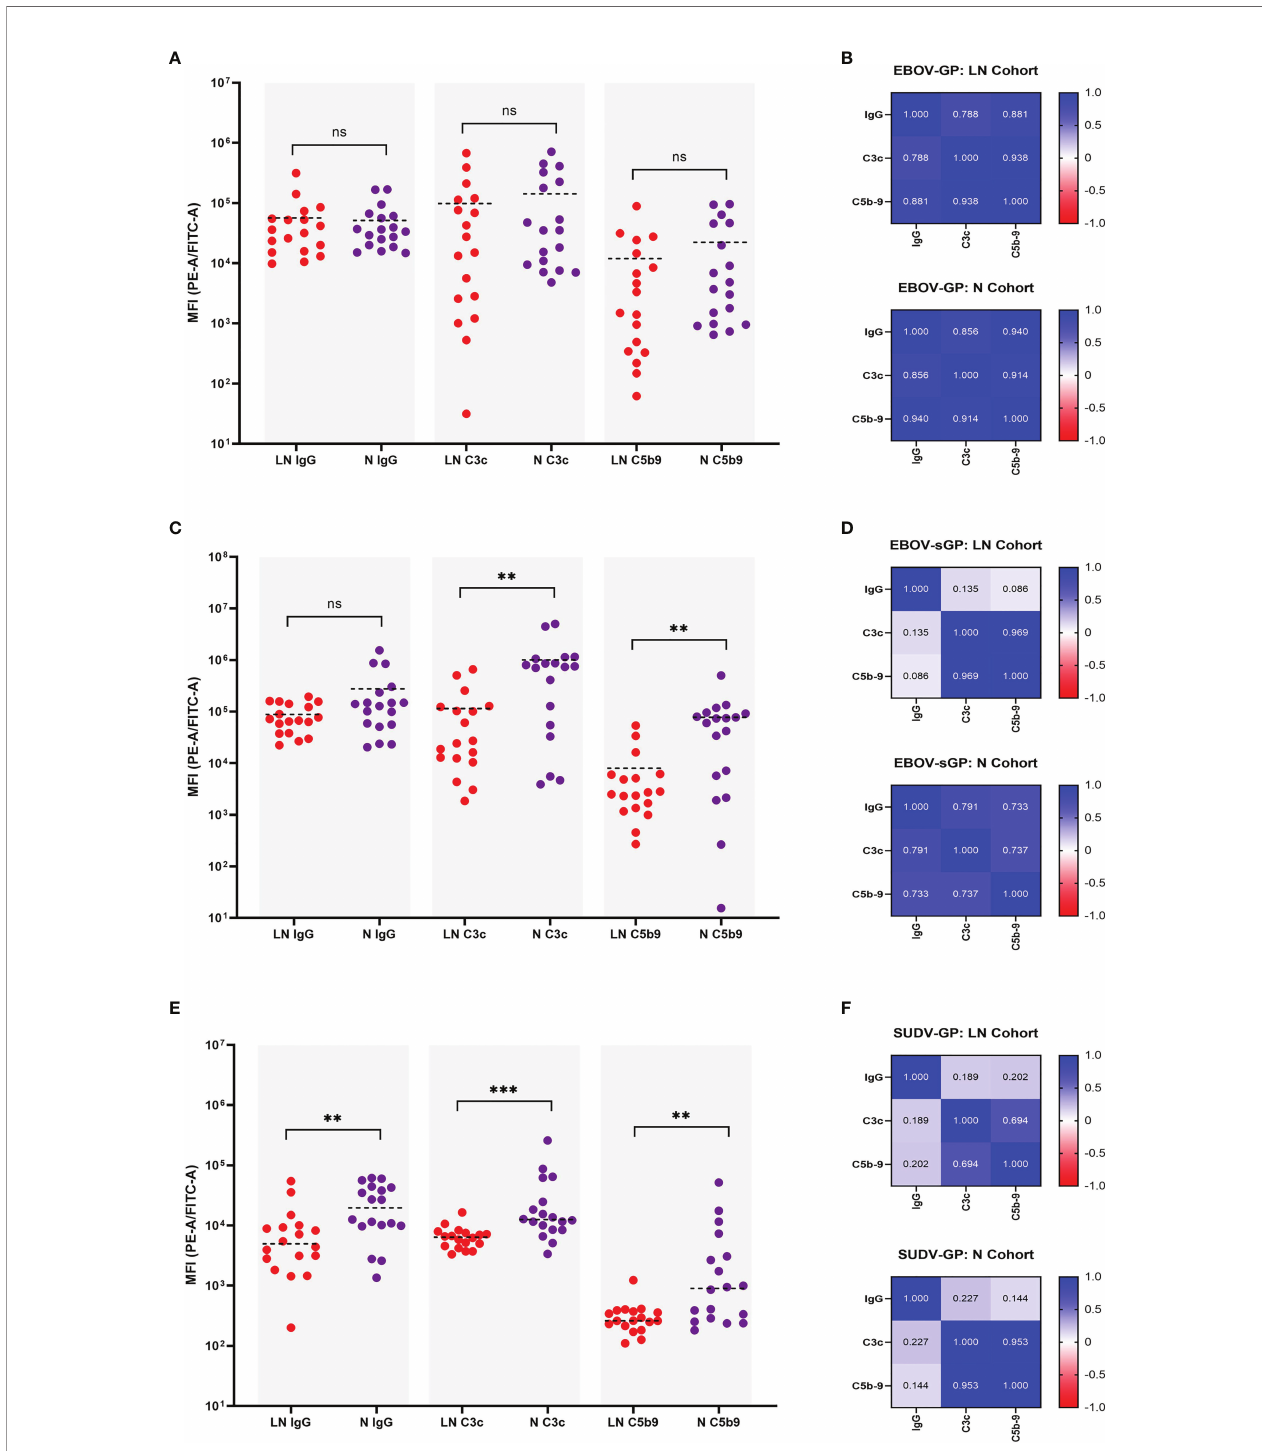
FIGURE 4 | Comparison of IgG binding, C3c deposition, and C5b-9 deposition for EBOV-GP, EBOV-sGP, and SUDV-GP. Plasma samples in the N cohort (purple dots, n = 18) and LN cohort (red dots, n = 18) were compared using a Mann-Whitney U test for IgG binding, C3c deposition and C5b-9 deposition against EBOV- GP (A) , EBOV-sGP (C) , and SUDV-GP (E) . The pairwise relationship between each parameter for both cohorts was then analysed via linear regression and the R 2 values reported as a heatmap for EBOV-GP (B) , EBOV-sGP (D) , and SUDV-GP (F) . Grey shaded areas group the samples based on assay type. ** = signi fi cant (P < 0.01), *** = signi fi cant (P < 0.001), ns, not signi fi